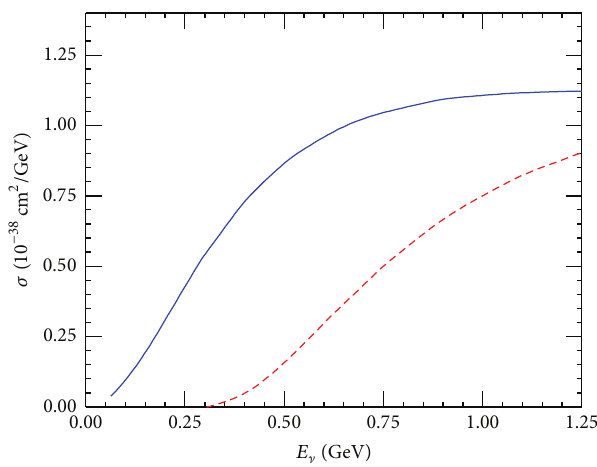
Figure 3: QE (solid line) and resonance production (dashed line) contributions to the charged-current neutrino-nucleon scattering cross-section (adapted from